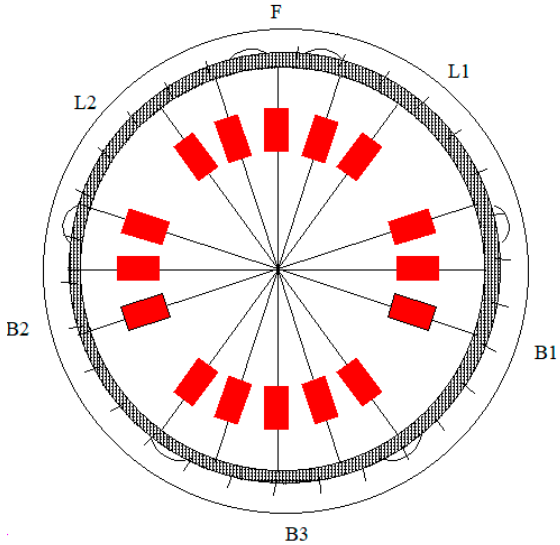
Figure 9. Sensor arrangement scheme of each